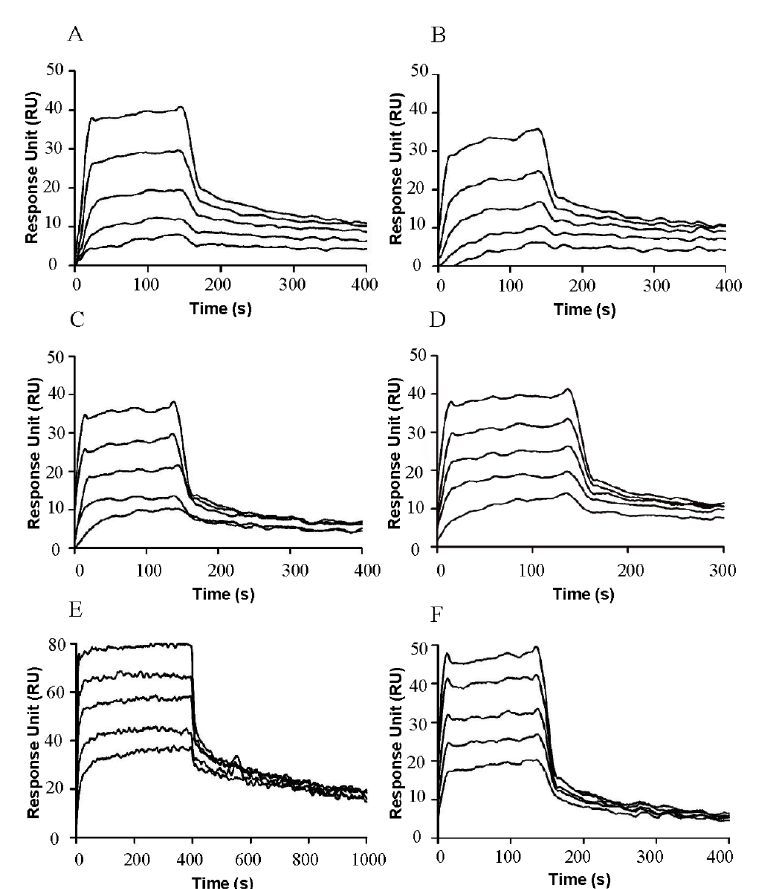
Figure 3. Affinities of SCF variants for c-Kit . The association and dissociation of the soluble SCF variants to and from surface-immobilized c-Kit. ( A ) Non-glycosylated SCF WT ; ( B ) Glycosylated SCF WT ; ( C ) SCF M ; ( D ) SCF M,K91E ; ( E ) SCF K91E,L98R ; and ( F ) SCF M,S64P,F126S,V131A,E134G,V139I .